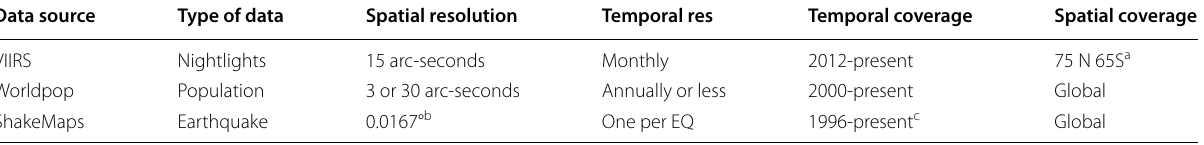
Table 1 Overview of the different data